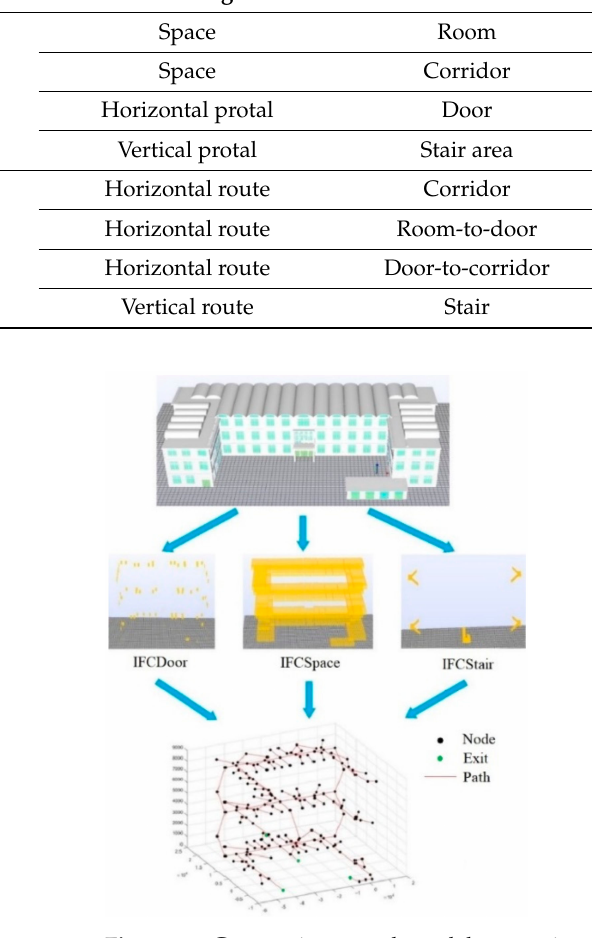
Figure 11. Geometric network model